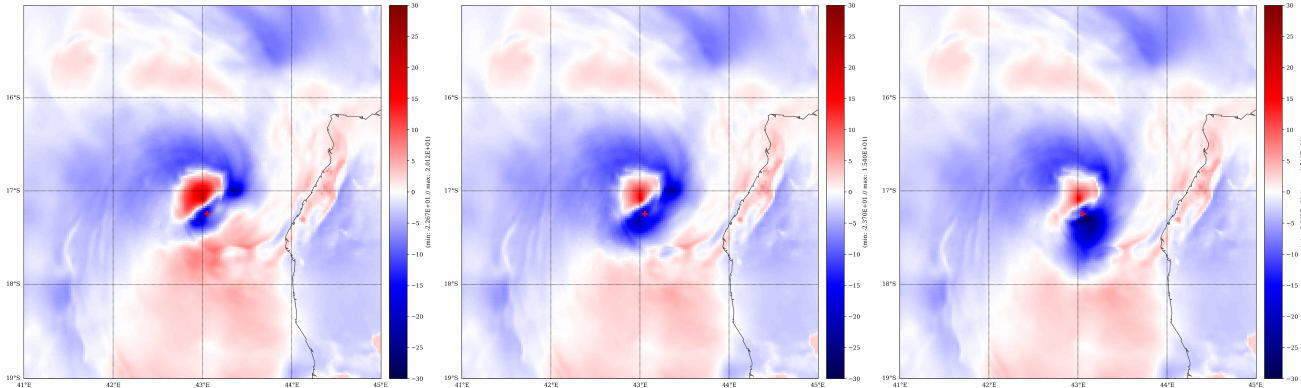
Figure 26. Analysis increments for surface wind speed for SAR_12km_2ms ( left ), SAR_12km_max30 ( middle ), SAR_12km_no30 ( right ). Units are m · s − 1 . Red cross is the estimated TC center position interpolated from TC position extracted from BT on 11 March 2019 00:00Z and